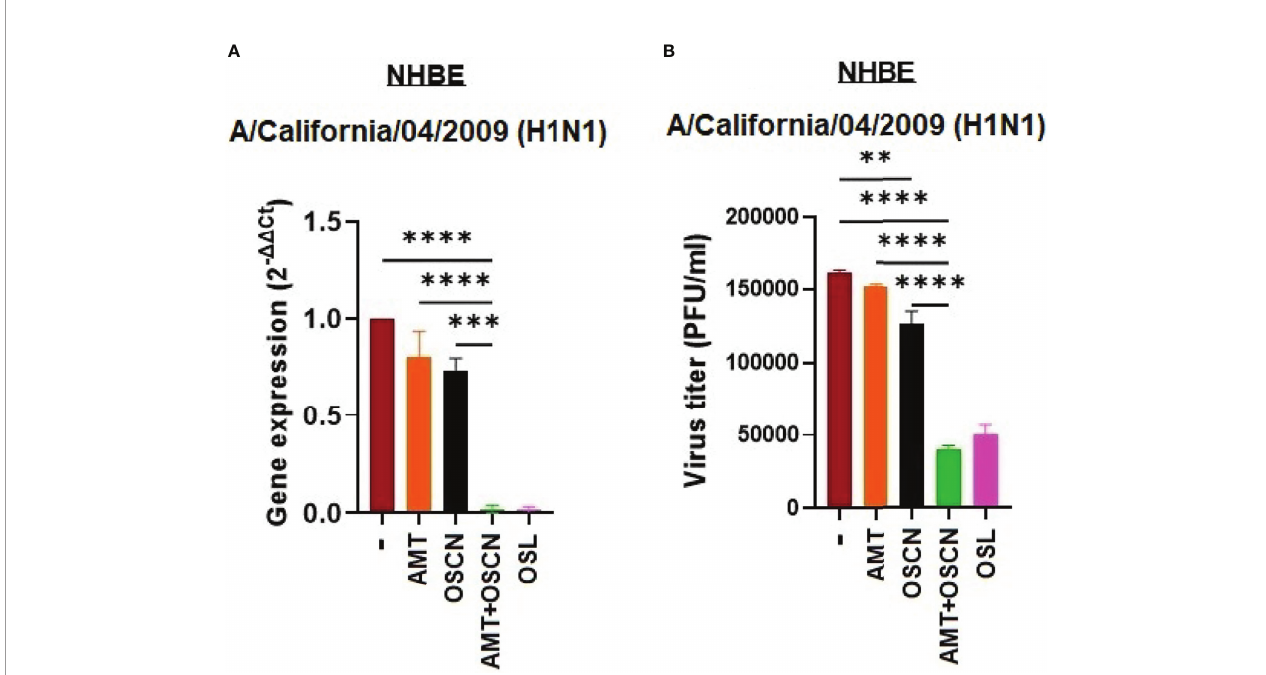
FIGURE 5 | The AMT+OSCN − combination treatment restricts in fl uenza virus replication in primary human bronchial epithelial cells. Primary normal human bronchial epithelial (NHBE) cells were infected with 100 MOI of the A/California/04/09 (H1N1) in fl uenza A virus strain under the indicated conditions for 1 h. (A) mRNA expression was measured using real-time qPCR. b -Actin was used as reference. OSL was used as a positive control. (B) Viral proliferation was assessed using PFU assay. Data are expressed as mean ± SEM of n = 3 independent experiments performed in triplicates. One-way ANOVA and Tukey ’ s multiple comparisons tests. AMT, amantadine; MOI, multiplicity of infection; NHBE, normal human tracheobronchial epithelial cells; OSCN − , hypothiocyanite; OSL, oseltamivir; PFU, plaque-forming unit. **, p < 0.01; ***, p < 0.001; ****, p <